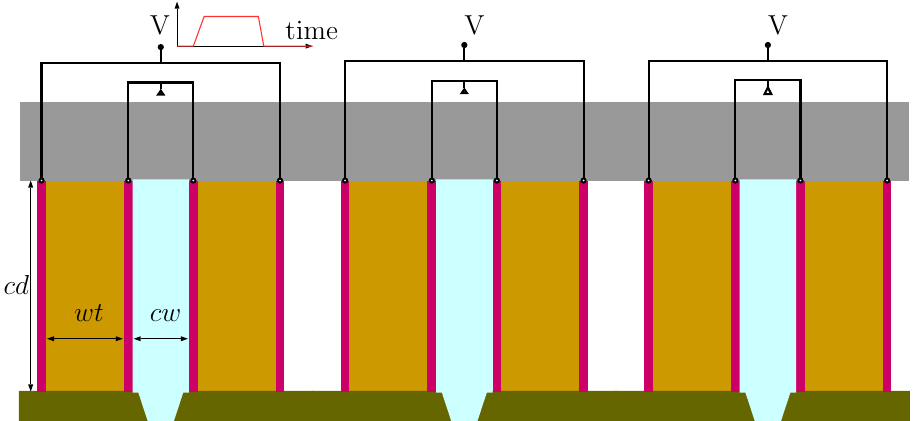
T 0 Figure 1. Sketch of RC1536 inkchannel including the piezoelectric actuator wall with attached electrodes, cover plates, nozzle plate, and ink chamber. Here, cd , cw , wt are the channel depth, channel width, and wall thickness of the channel. The image is not to scale.